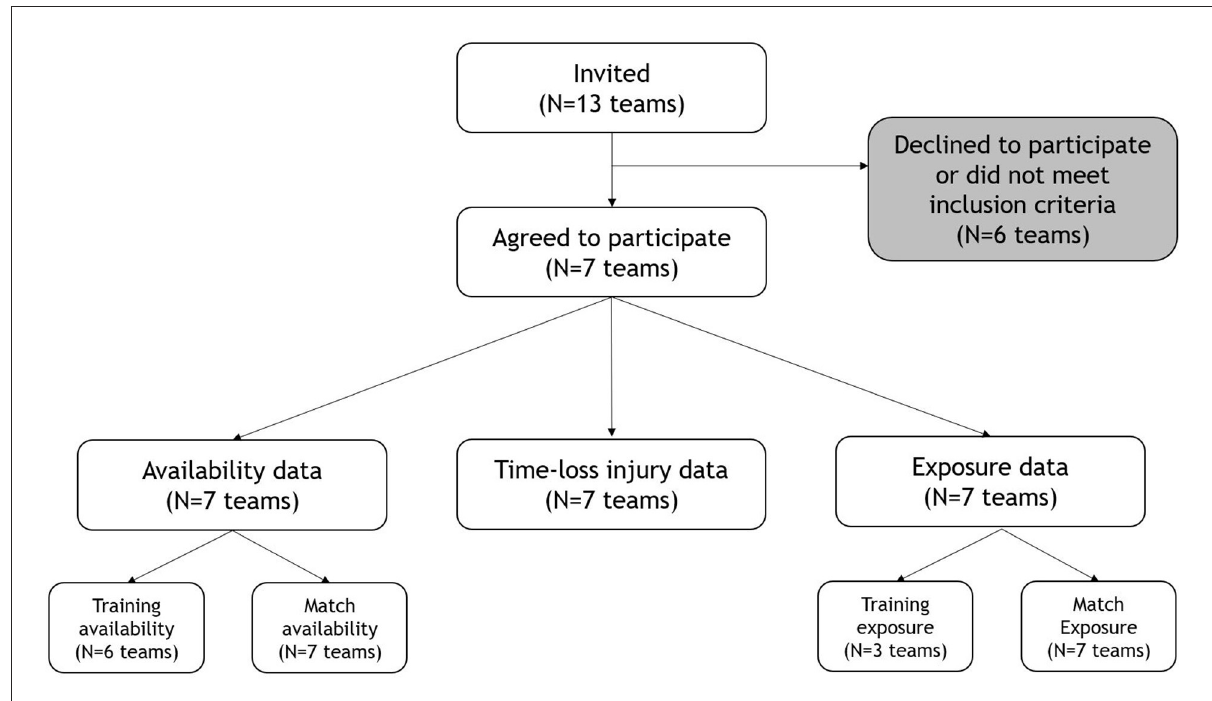
FIGURE2 Flowchart of teams invited to participate in the study and the information obtained from the teams that were included. Thirteen teams were eligible as they were part of both the 2019 and 2020 campaigns.